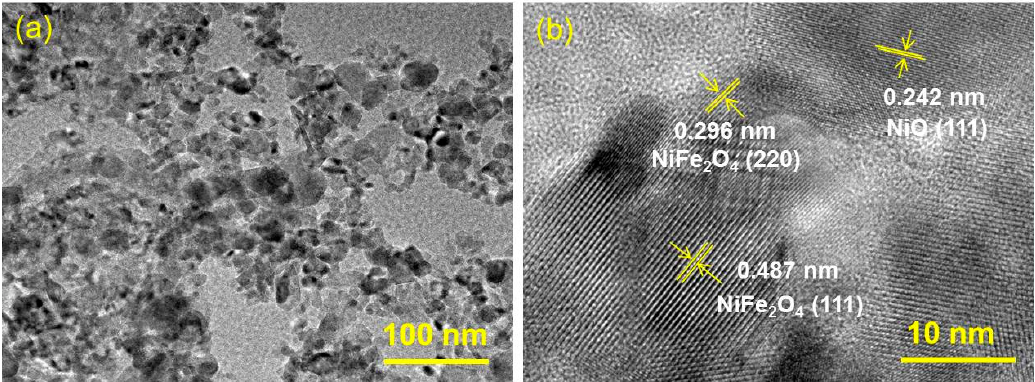
Figure 3. ( a ) Transmission electron microscope (TEM), image and ( b ) HRTEM image of NiO-NiFe 2 O 4 -rGO.